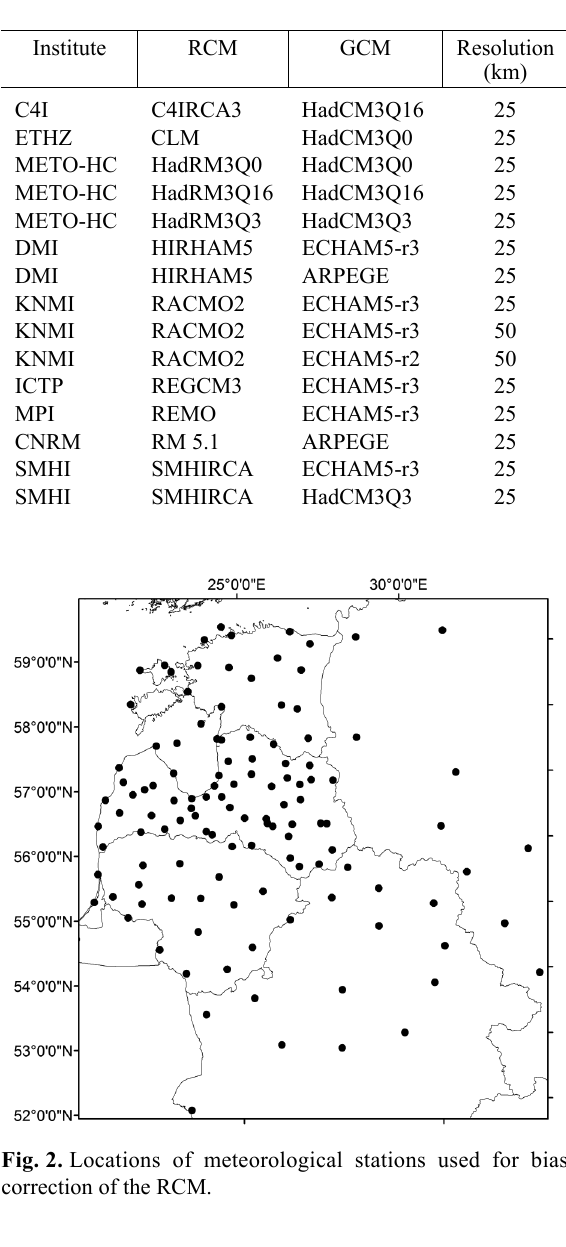
Table 2. List of the Regional Climate Model (RCM) ensemble members used (ENSEMBLES), showing the originating institution, the name of RCM, the driving General Circulation Model (GCM) and the grid size. For explanation of abbreviations see van der Linden & Mitchell (2009)